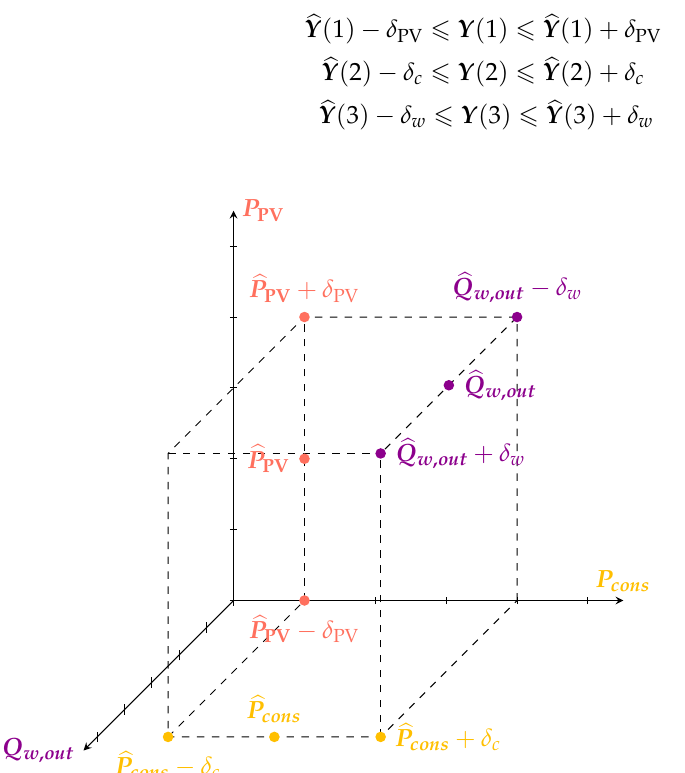
Figure 4. Feasible space of the min–max problem, defined by the confidence intervals of one-step- ahead forecasts of grid load, water demand, and PV power generation. The time indices are removed to avoid cluttering the illustration. All quantities in this figure correspond to values in the next time